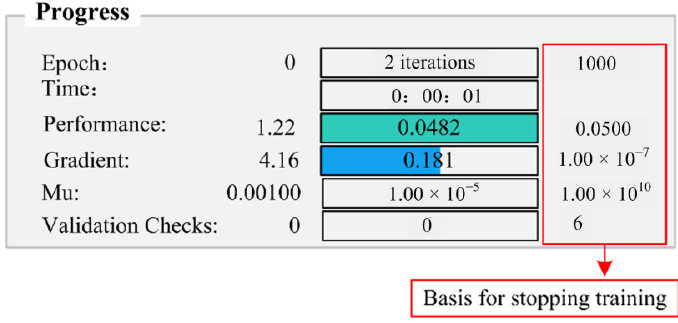
Figure 11. BP net training process.